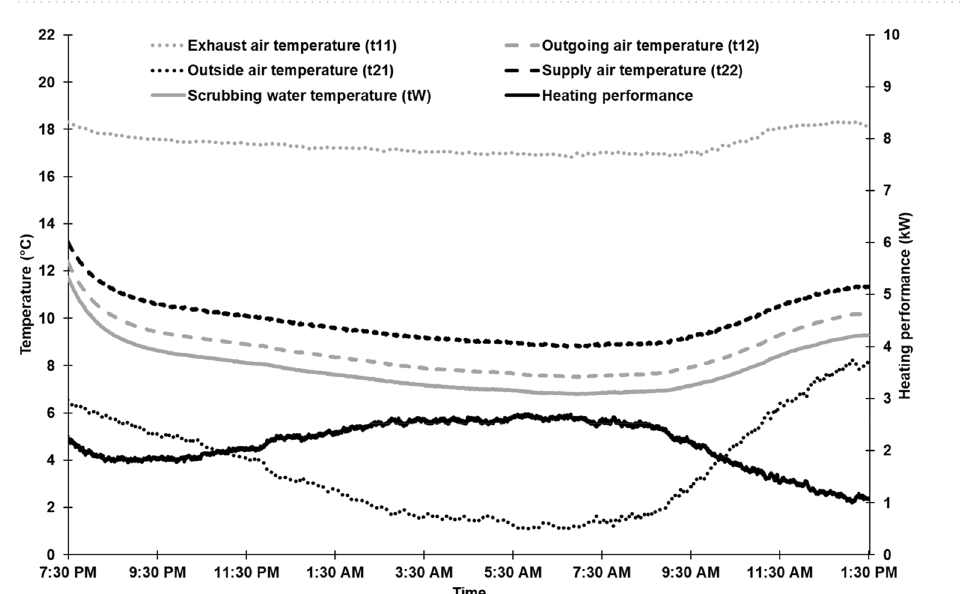
Figure 2. Heating performance and temperature profiles at the measuring points of the exchange scrubber pilot-plant of a single measurement during the experimental period (February 29th/March 1st, 2016; assembly situation B of the heat exchanger at 1000 m 3 h −1